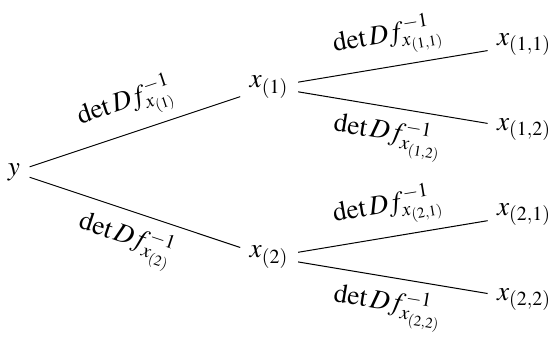
Figure 9: The probability tree associated to the preimages of y , for k = 2 and d = 2. We have f ( x D ISCRETE A NALYSIS , 2019:1,